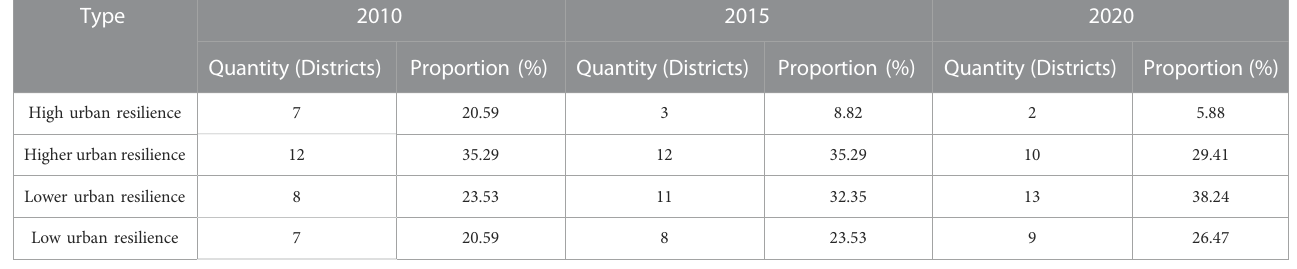
TABLE 7 Types of urban resilience levels in the study area.